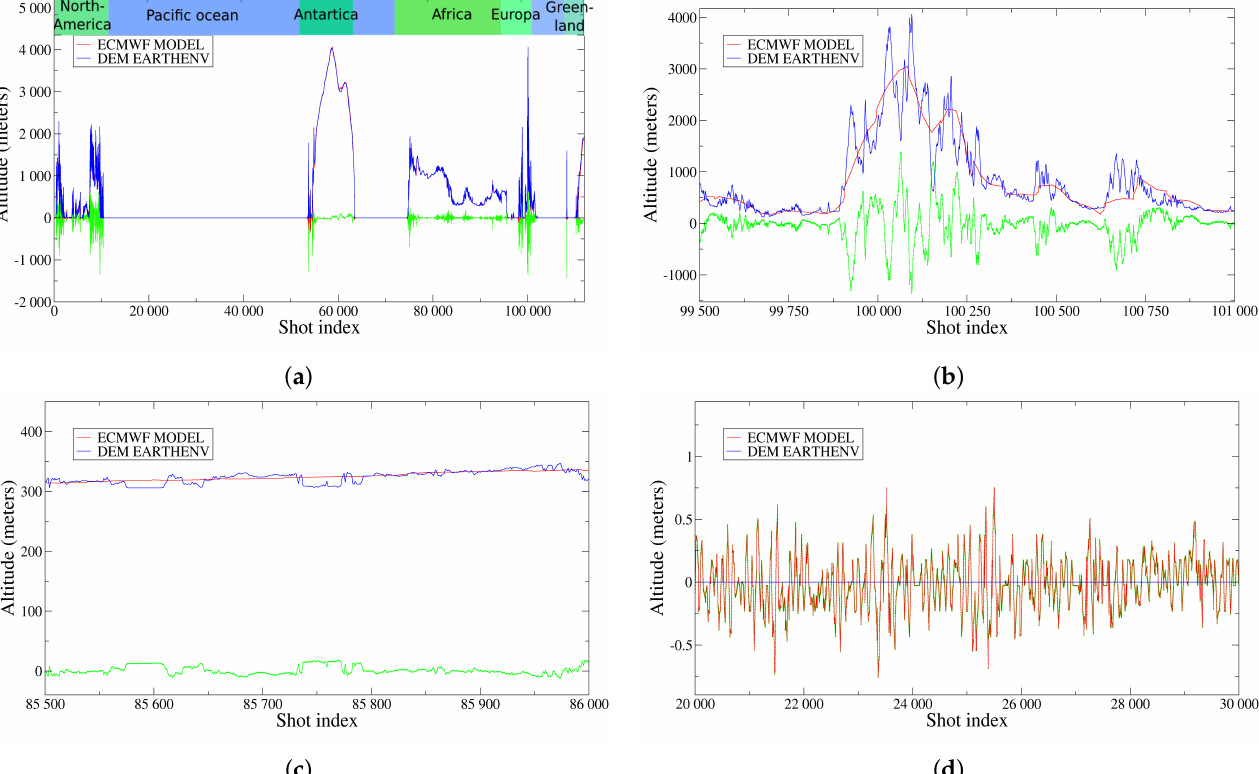
Figure 2. Comparison between the meteorological model topography (red) and the numerical elevation model used [15] (blue). The difference is in green. ( a ) For a complete orbit starting north of Canada, descending over the Pacific to Antarctica, ascending over Africa and the Alps, before ending over Greenland. The shot index corresponds to the position in the simulated orbit. ( b ) A zoom on the Alps region where the difference sometimes exceeds 1 km. ( c ) A zoom on a flat area, the differences are about 20 m. ( d ) Over the sea, the differences are not zero because of the Gibbs phenomenon affecting the model topography, but they are less than 1